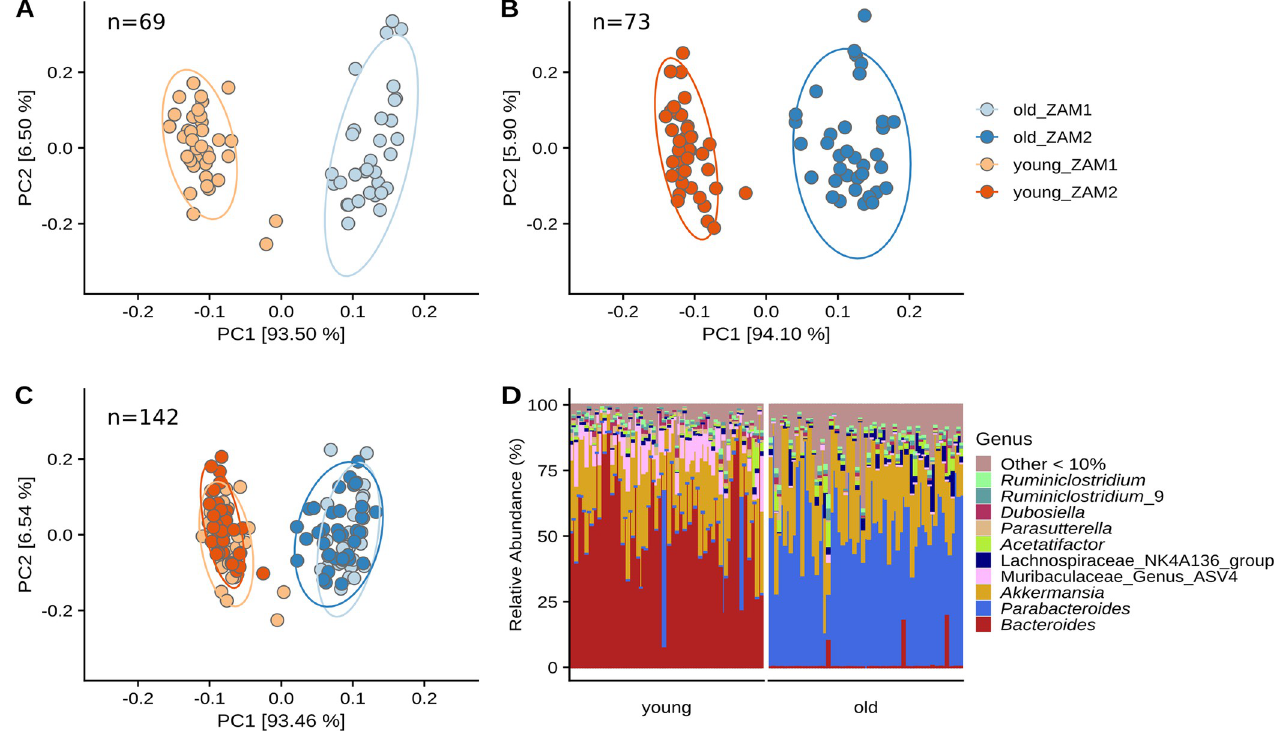
Fig 1. The majority of the variance in the mouse gut microbiome can be explained by age. Robust principal component analysis results are shown for ZAM1 (zinc supplemented), ZAM2 (zinc deficient) and combined, respectively (A-C). Age explains the majority of the variance in beta diversity in both studies. Relative abundances of ASVs agglomerated at the genus level are shown (D). Bacteroides and Parabacteroides are the most abundant genera in young and old mice, respectively. n = 69 for ZAM1, n = 73 for ZAM2, and n = 142 for combined beta diversity and stacked barplot analysis of week 0 and week 6 fecal